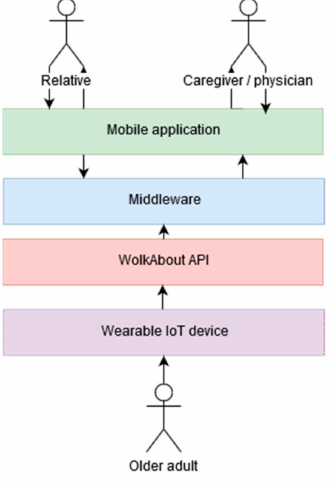
Figure 1. System architecture of Abuel ó metro.